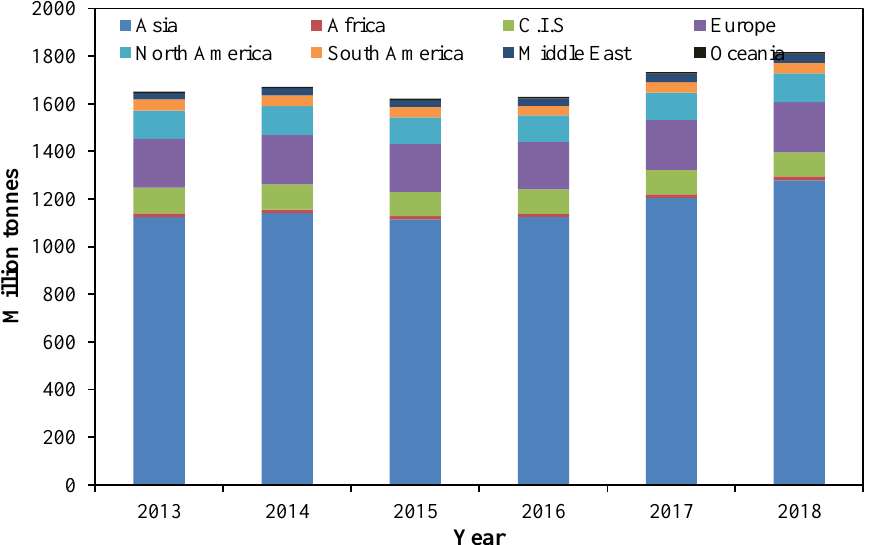
Figure 1. Total amount of steel products produced from 2013 to 2018 for different regions worldwide [3].